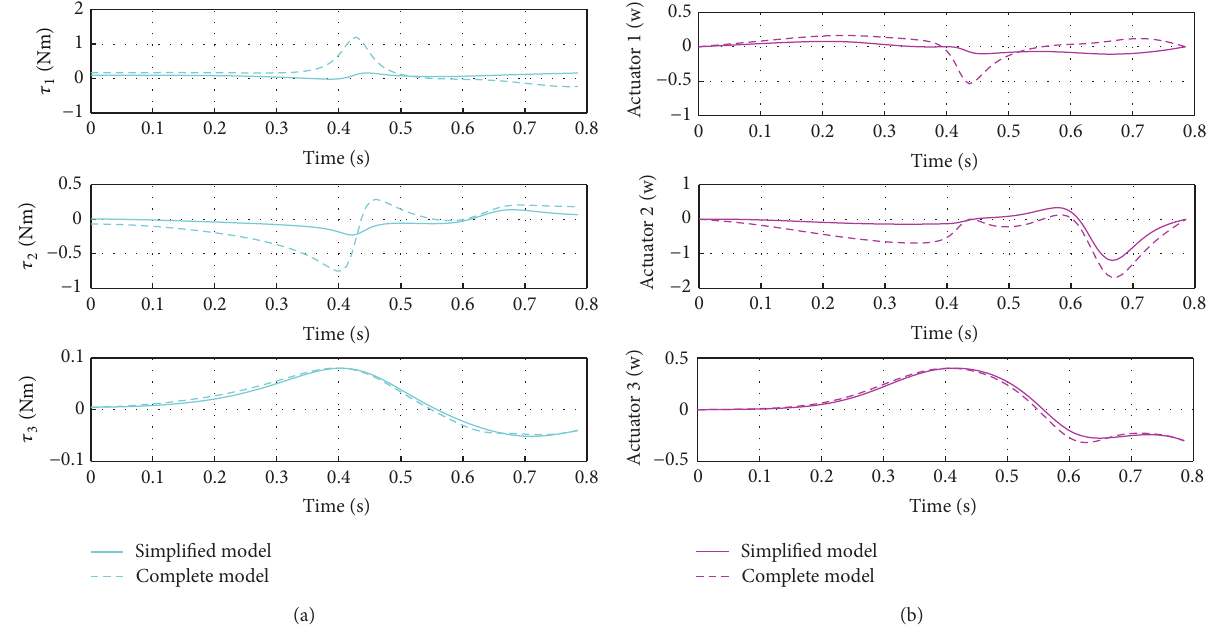
Figure 9: The dynamic simulation results of trajectory 2: (a) actuator torque; (b) actuator power.